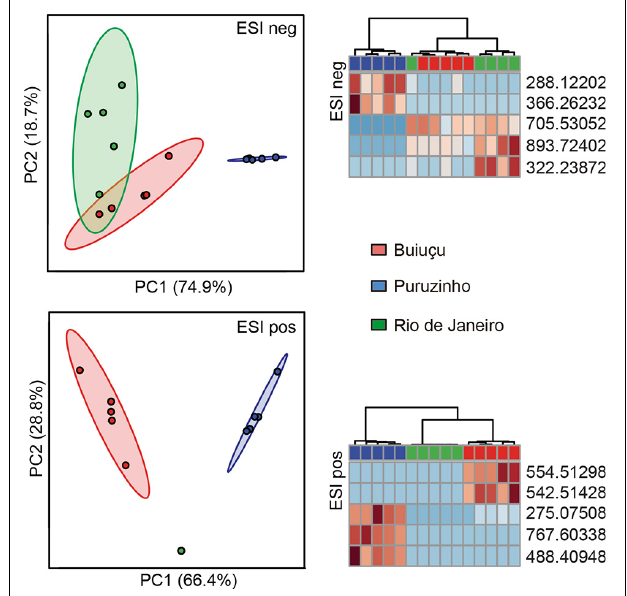
FIGURE 5 | Principal component analysis, heat maps and dendrograms of the 5 top ions from DI-FTICR-MS data. The top 5 ions regarding their discriminatory power were selected and PCA plots and heat maps were constructed based on their intensities. Only ions that were present in a minimum of n -1 replicates of at least one of the three sample groups were included. Data for negative (ESI neg) and positive (ESI pos) ionization modes are shown. In PCA, some of the data points can not be clearly seen due to overlapping ( n = 5 in all groups). In heat maps each column represents one sample, with the top rectangle indicating the source of the sample: red rectangles represent samples from the Buiuçu community, whereas blue rectangles are for Puruzinho samples and green are for Rio de Janeiro samples. Each line in the heat maps represent one ion, and colors indicate levels of each ion compared to the intra-sample average. Red indicates ions detected at levels higher than the average whereas blue represents ions that were found in levels lower than the